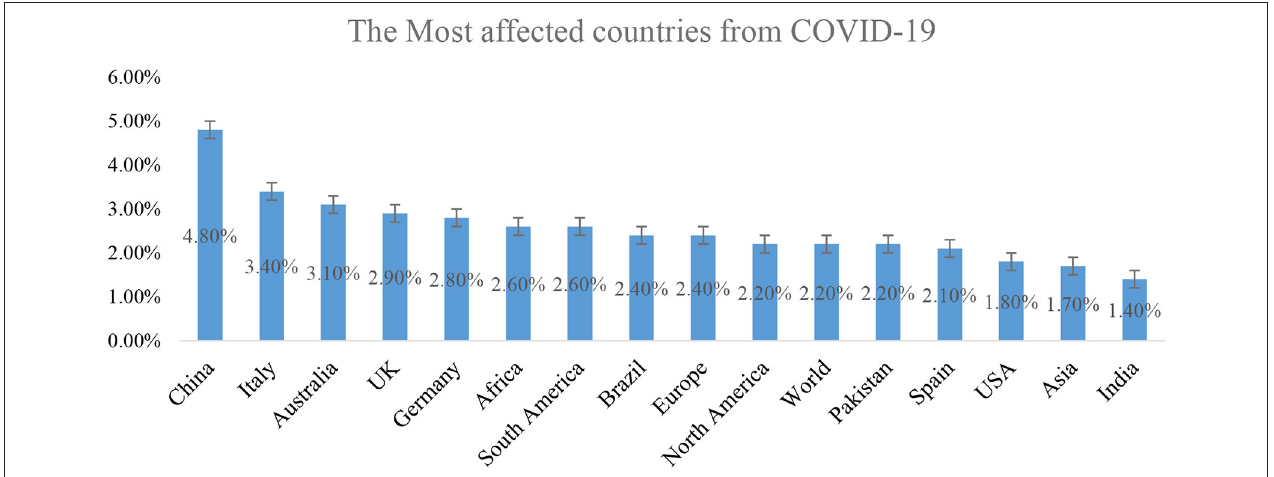
FIGURE 3 | COVID-19 Case-fatality-rate (CFR) worldwide - February 15, 2021.